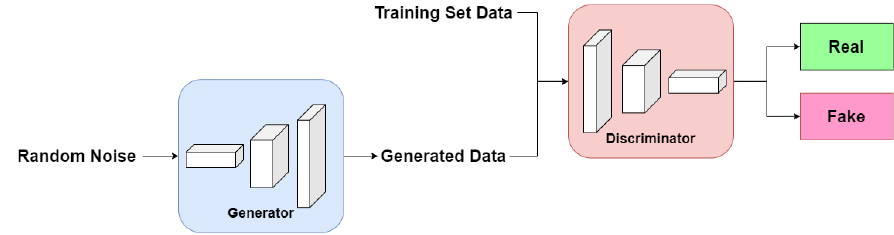
Figure 2. Generative adversarial